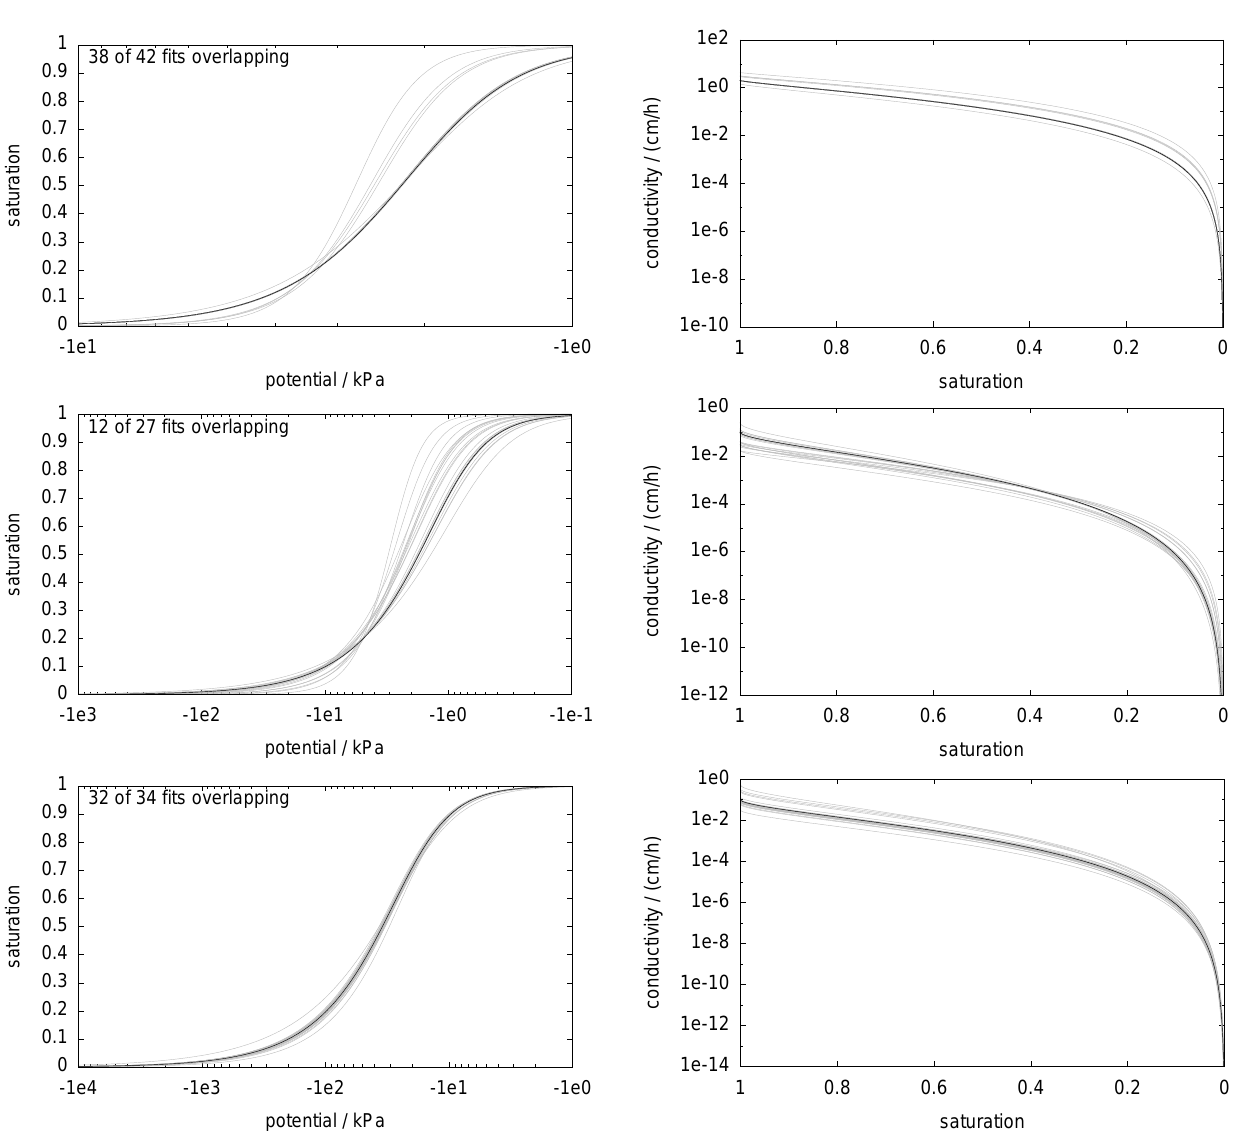
Fig. 16. Hydraulic functions of the inverse solutions (grey), and the functions for the true parameters (black line), for the sand (top, 42 fits, 38 practically overlapping), sandy loam (middle, 27 fits, 12 practically overlapping), and silt (bottom, 34 fits, 2 deviating slightly),